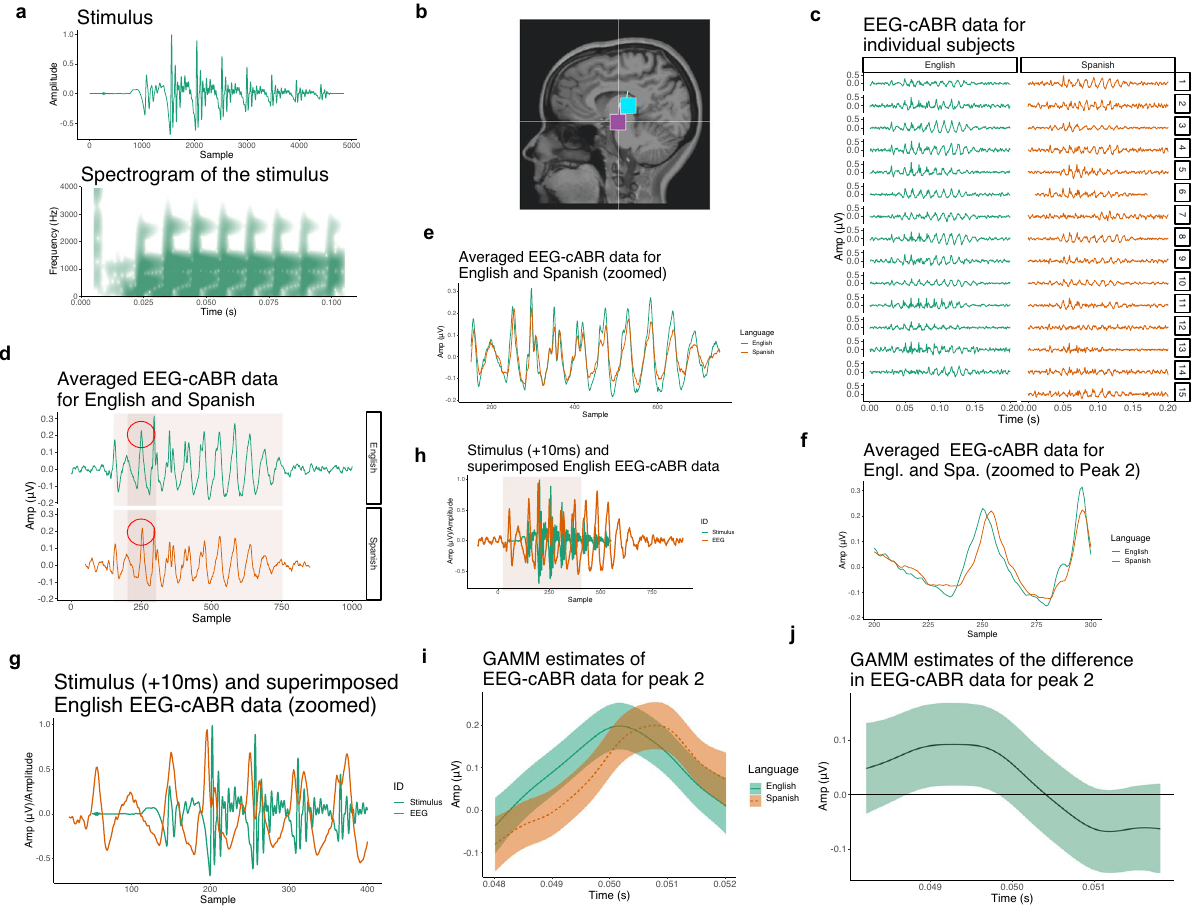
Figure 1. ( a ) Synthesized stimulus used in the cABR experiment with a spectrogram (0–4000 Hz). This stimulus is also used in the computational experiments when the Generator is forced to output data with the objective to minimize the distance between generated data and the stimulus. The stimulus is played to subjects in the experiment. ( b ) The figure illustrates the dipole location of the onset peaks recorded during the cABR experiment for one speaker as localized in Zhao and Kuhl 47 (magenta = peak 1, cyan = peak 2). The location suggests the recorded brain activity is indeed localized in the brain stem. Figure in ( c ) shows cABR recordings averaged for each subject across the 3000 trials. ( d ) Individual subjects’ recordings are averaged for each language (with shades that indicate which parts are zoomed in in the following figures). Peak 2 is circled in red. ( e ) Zoomed cABR data for English and Spanish showing that most peaks (with the exception of peak 2) are almost perfectly aligned across the two languages. ( f ) Zoomed peak 2 showing peak latency differences between English and Spanish. Figure in ( h ) superficially parallels the stimulus with the cABR data. The brain signal in the experiment is manually delayed relative to the stimulus; for illustration, we manually aligned the two time-series by approximately aligning the burst of the stimulus and the first peak of the cABR data. Shaded part indicates the area zoomed in ( g ). ( i ) Predicted values of a Generalized Additive Mixed Model with Amplitude in µ V across time and the two languages (English vs. Spanish). For more details about the model, see Supplementary Table S2 and “A new statistical analysis” section. ( j ) Difference smooth between English and Spanish cABR data. The area on the time scale (x-axis) in which the difference smooth’s confidence interval do not cross zero indicates significant difference in the cABR signal between the two speakers identified the stimulus as /pa/, as reported in a previous behavioral experiment 47 . Individuals’ cABR (localized in Fig. 1a) were calculated by averaging across all available trials after standard preprocessing and trial rejection. Averaged values are visualized in Fig. 1c. Further, the group-level cABR can be visualized by averag- ing over all subjects. The monolingual English group and the native Spanish group are represented in Fig. 1d–h. cABR data acquisition. The details of the recording methods can be found in Zhao and Kuhl 47 . Specifi- cally, the cABR reported here is recorded using a traditional set-up of 3-EEG channels (i.e., CZ electrode on a 10-20 system, ground electrode on the forehead and the reference electrode on the right earlobe 46 ). Two blocks of recordings (3000 trials per block) were completed for each participant where trials were alternating in polari- ties.